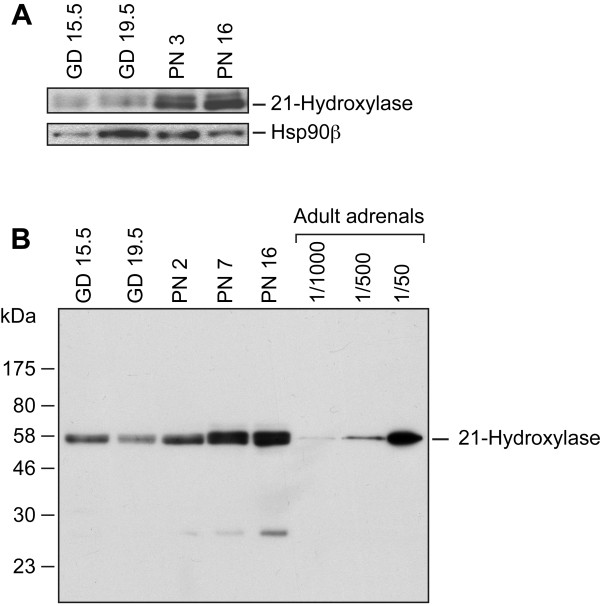
21-hydroxylase protein in the mouse developing lung. A Western blot analysis of the 21-hydroxylase protein is presented for whole lung protein extracts (50 μg) (panel A) and microsomal fractions (50 μg of microsomal proteins) (panel B) for the indicated developmental times. For the study of total protein extracts, levels of Hsp90β are shown as a loading control. Total protein extracts were prepared with the lungs from one individual for each time point, whereas microsomal fractions were prepared using a pool of lungs from all the fetuses/neonates of one litter for each time point. Microsomes from adult adrenals were used as control. The proportion of adrenal microsomal proteins loaded on the gel compared to the amount loaded for the lungs is indicated (1/1000 = 50 ng microsomal proteins, 1/500 = 100 ng, and 1/50 = 1 μg). Each pannel corresponds to a different gel.